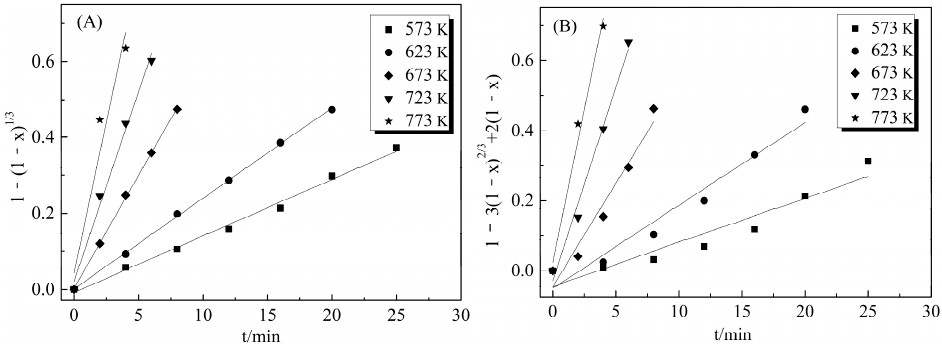
Figure 10. The linear fit of the reduction’s kinetic model; ( A ) surface chemical controlling; ( B ) inner diffusion controlling.